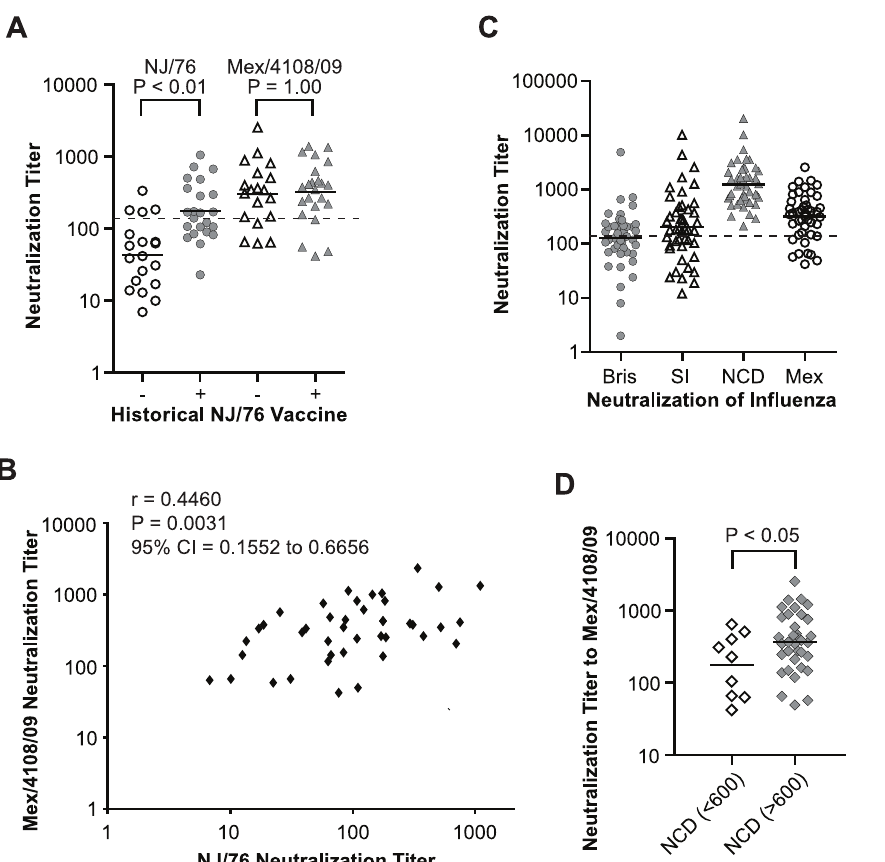
Figure 3. Relationship between 2009 H1N1 neutralization and immunizations with NCD/20/99 and NJ/76 vaccines. (A) Comparison of neutralization titers to NJ/76 and Mex/4108/09 in the contemporary cohort of subjects having received recent seasonal influenza vaccines with ( + ) and without ( 2 ) history of NJ/76 vaccination. P values were calculated by unpaired t test for the comparison of groups with ( + ) and without ( 2 ) history of NJ/76 vaccination. (B) Correlation between neutralizing titers to NJ/76 and Mex/4108/09 in the subjects aged 48–64 years with ( + ) and without ( 2 ) history of NJ/76 vaccination was evaluated with Spearman test for nonparametric correlation. r: Spearman r; P: two-tailed P value. (C) Neutralization titers to Bris/59/07, SI/03/06, NCD/20/99 and Mex/4108/09 in the subjects aged 48–64 years who had received all seasonal influenza vaccinations including Bris/59/07, SI/03/06 and NCD/20/99. (D) Neutralization titers to Mex/4108/09 in the subjects aged 48–64 years who had received all seasonal influenza vaccinations were stratified neutralization titer ( . 600) in NCD/20/99 vaccination. P values were calculated by unpaired t test for the comparison of the two stratified groups. The geometric mean of titers (GMT) of neutralization in each group is shown as a short dark line in panels A, C and D. The dotted lines in both panels A and C represent neutralization titer of 160, which has been proposed as a correlate of seroprotection in microneutralization assays involving replicating influenza virus [4]. Protective titers for neutralization of HA-pseudotypes have not been determined. Bris: Bris/59/07; SI: SI/03/06; NCD: NCD/20/99; Mex: Mex/4108/09.